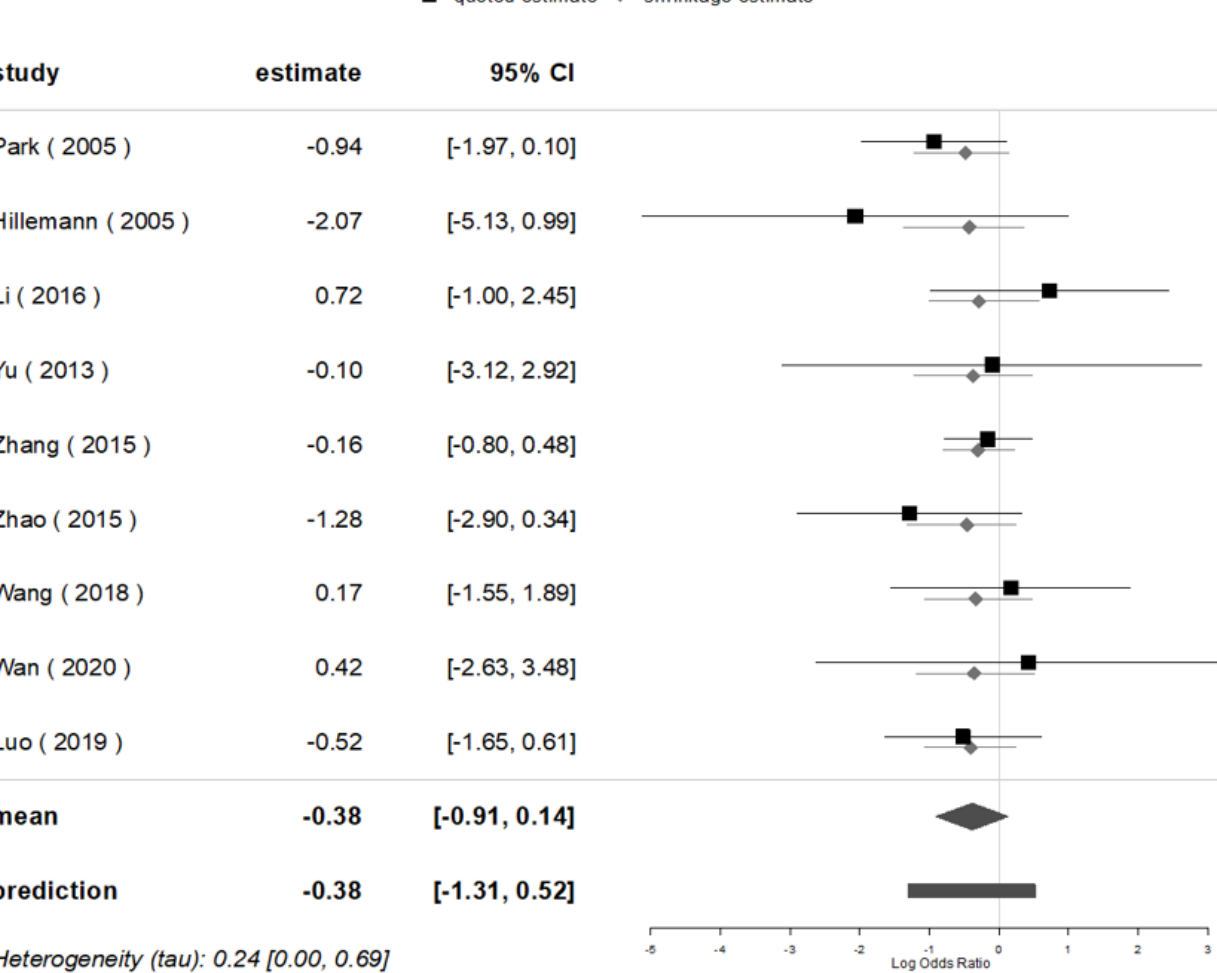
Figure 9. BM for the mutations of oxyR-ahpC in Beijing and non-Beijing strains.